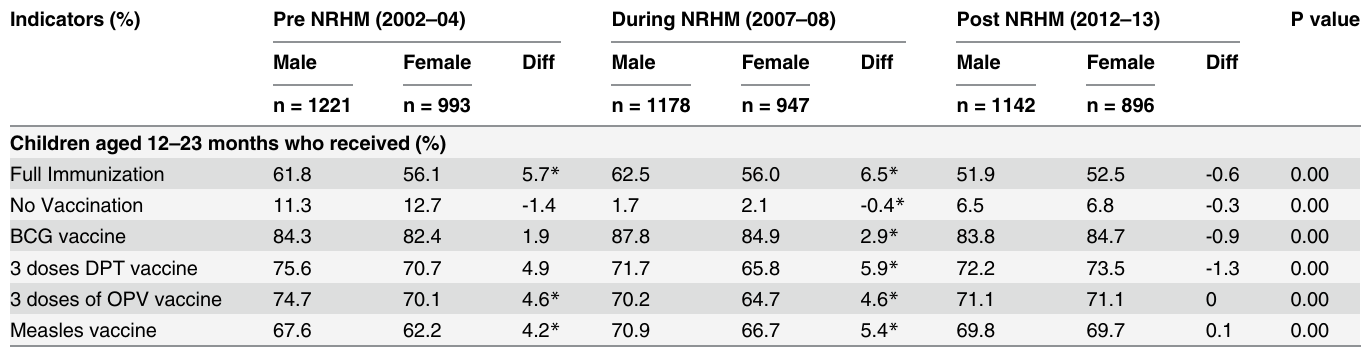
Table 3. Child based gender inequalities in Haryana (expressed as absolute difference in proportion of indicators among male and female children). Indicators